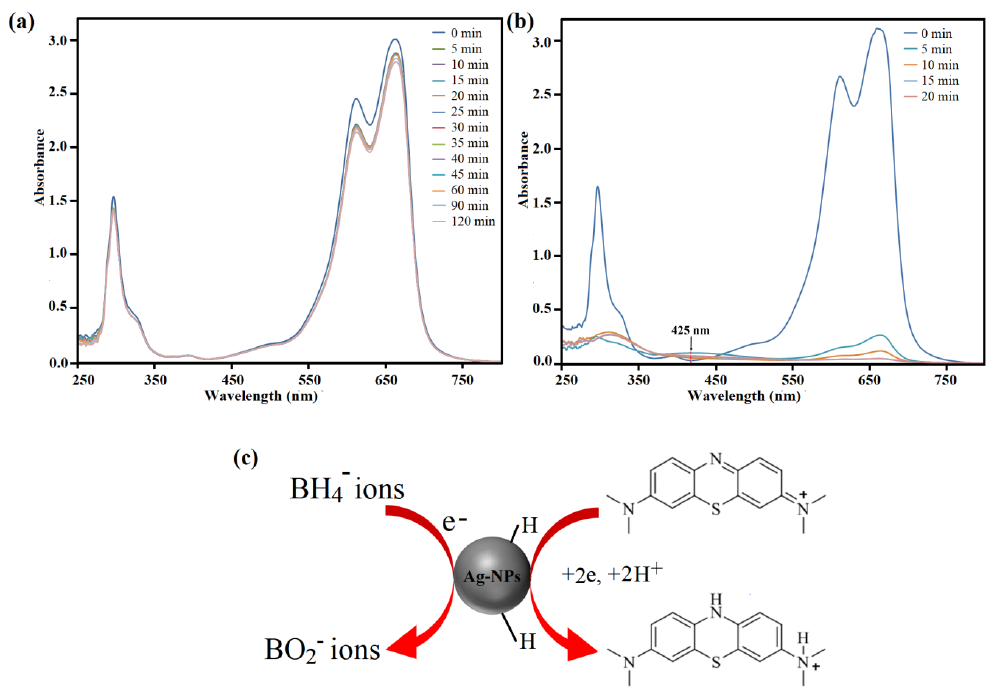
Figure 17. UV–vis spectra of reduction of MB dye by ( a ) NaBH 4 alone, ( b ) in the presence of C. pentandra / Ag-NPs and ( c ) the proposed mechanism of C. pentandra / Ag-NPs as nanocatalyst for the reduction of MB dye.